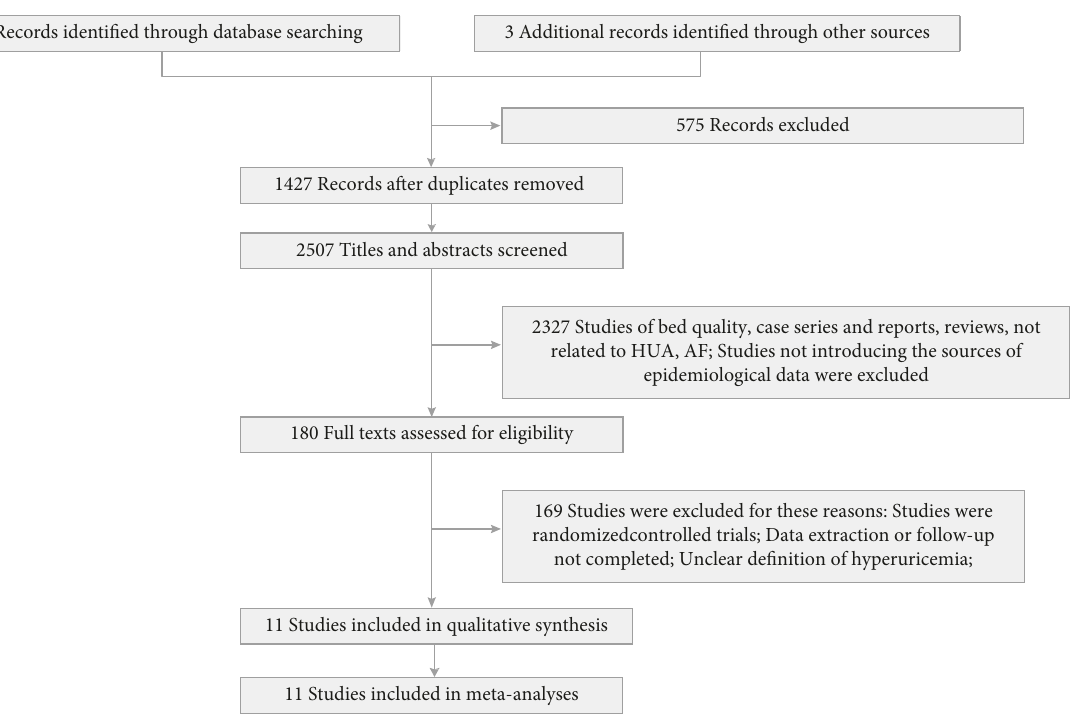
Figure 1: PRISMA flow diagram summarizing the article selection